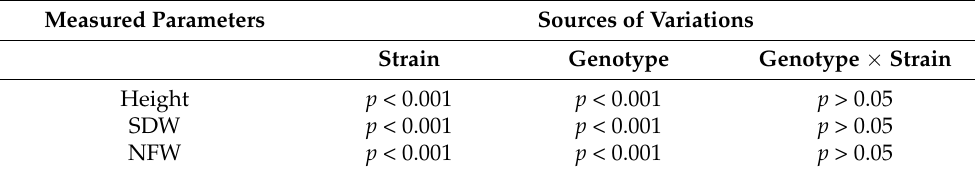
Table 2. Analysis of Variance (ANOVA) results of the effect of the Mesorhizobium strains and chickpea genotype on the height, shoot dry weight (SDW), and nodule fresh weight (NFW) of inoculated plants.